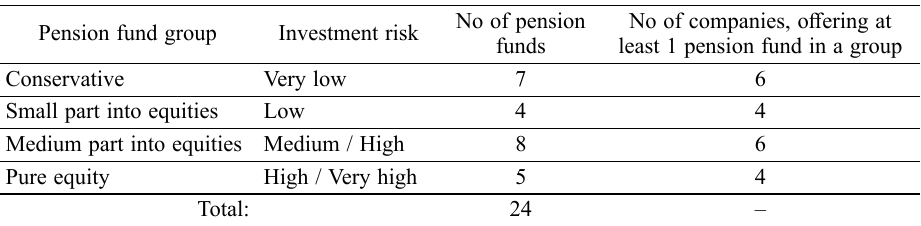
Table 1. Breakdown of second pillar pension funds according to investment risk in Lithuania Pension fund